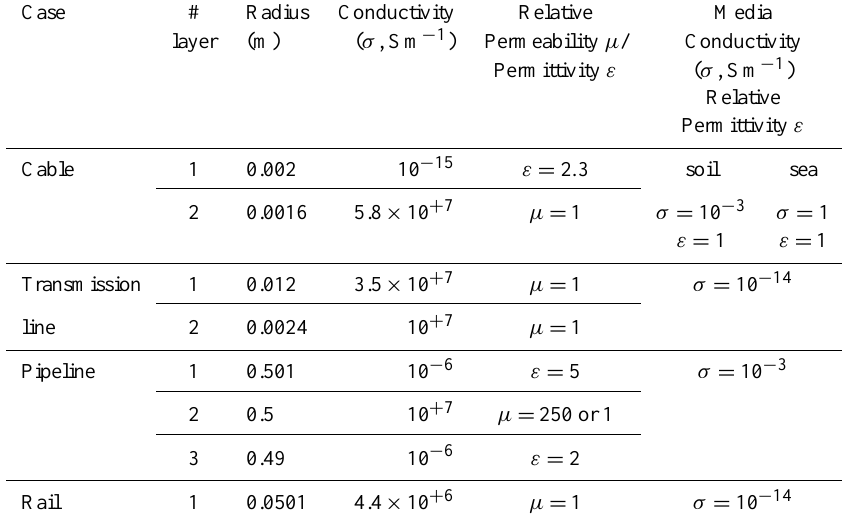
Table 1. The electromagnetic parameters and dimensions. Case # Radius Conductivity